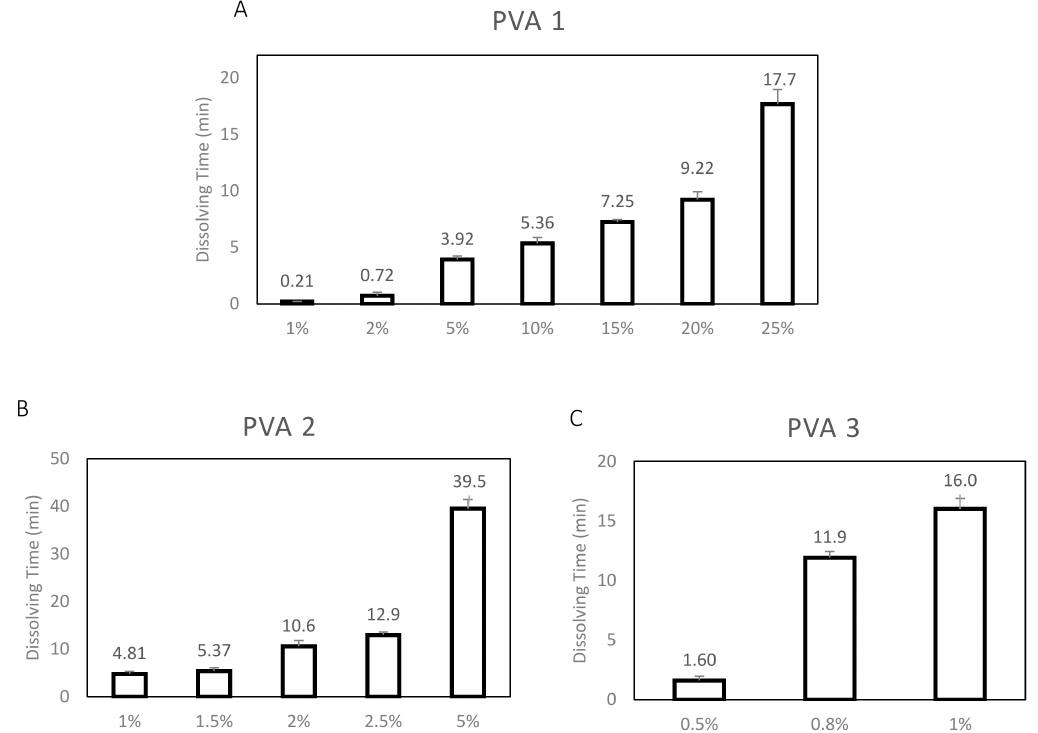
Figure 3. Comparison of PVAs 1–3 films dissolving time in DI-water. The dissolution time was determined after immersing the PVA films into 100 µ L of DI-water droplet on parafilm. Dissolution time was compared between three types of PVA: ( A ) PVA 1 (Mw: 30–70 K, 89–90% Hydrolysed); ( B ) PVA 2 (Mw: 31–50 K, 98–99% Hydrolysed) and ( C ) PVA 3 (Mw: 89–98 K, 99% Hydrolysed). Different concentrations were selected for each PVA type, according to the Mw and hydrolysis